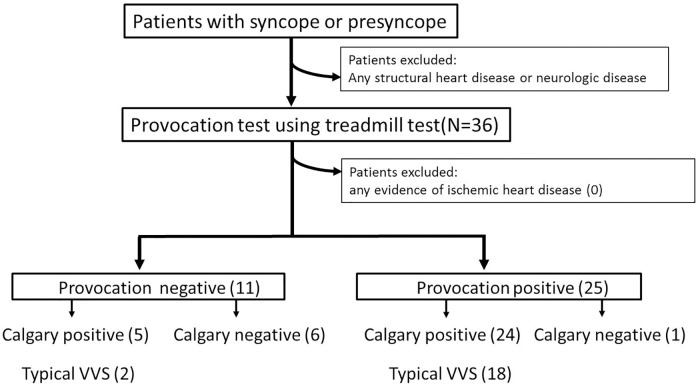
A flow diagram demonstrates the sequence of patients’ enrollment and the test results.The each group’s patients by the provocation test result are classified again by the definition of the Calgary score and that of the typical (classic) vasovagal syncope.